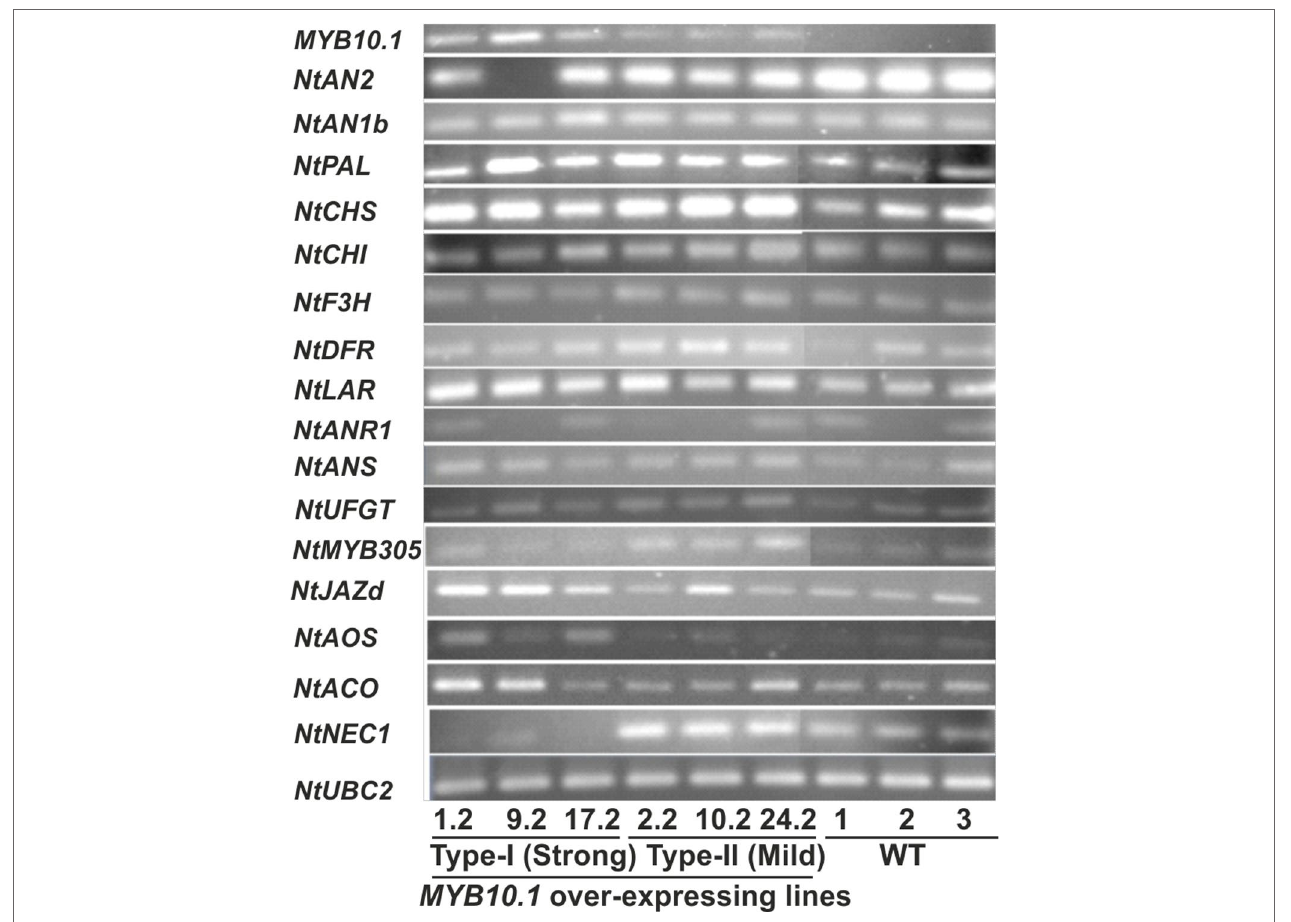
FIGURE 5 | Expression patterns of anthocyanin biosynthetic and flower development genes by RT-PCR in flowers of six independent transgenic and three WT tobacco lines at anthesis. The PCR cycle number was optimized for each gene, and the Nicotiana tabacum (Nt) ubiquitin conjugating enzyme E2 encoding gene (NtUBC2, Koyama et al., 2003) was used as a control for equal loading. The genes included in the expression analysis are as follows: MYB10.1, peach MYB10.1 TF gene; NtMYB305, tobacco MYB305 TF gene orthologous of Arabidopsis stamen filament growth related genes AtMYB21, AtMYB24 and AtMYB57 (Cheng et al., 2009); NtPAL, phenylalanine ammonia-lyase; NtCHS, chalcone synthase; NtCHI, chalcone isomerase; NtF3H, flavanone-3-hydroxylase; NtDFR, dihydroflavonol 4-reductase; NtLAR, leucoanthocyanidin reductase; NtANR1, anthocyanindin reductase 1; NtANS, anthocyanidin synthase; UFGT, udp-glycose:flavonoid-3-o- glycosyltransferase; NtJAZd, encodes a jasmonate ZIM-domain protein; NtAOS, allene oxide synthase, NtNEC1, nectarin 1; and NtACO, 1-aminocyclopropane-1- carboxylate